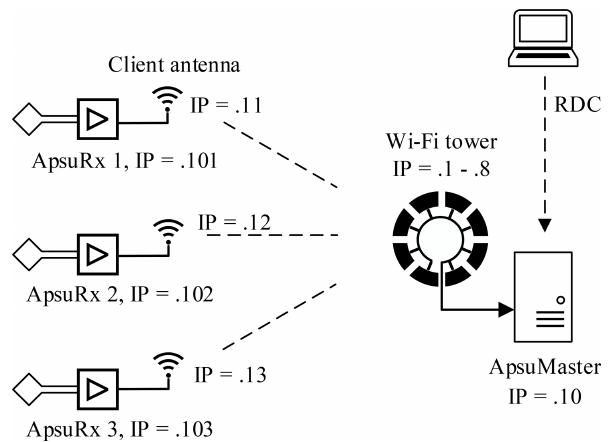
Figure 5. Topology of the network of wireless surface-NMR instru- ment Apsu. The network mask is 255.255.255.0, and only the host numbers of the IP address are